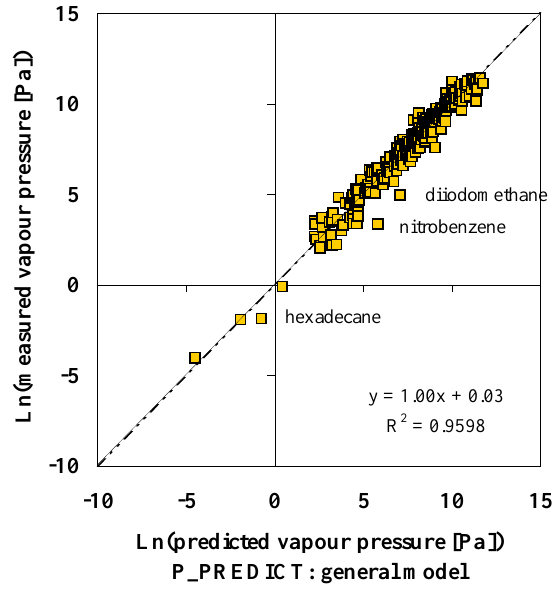
Figure 5. Test of P_PREDICT. General model for prediction of ln p from the compounds’ chemical (UNIFAC) structure. The line, which fits the data best, is of the general form: y = (1.00 ± 0.01) x + (0.02 ± 0.10). n = 294. Average bias of prediction is -0.02, SEP is 0.51, and RMSEP is 0.51 log